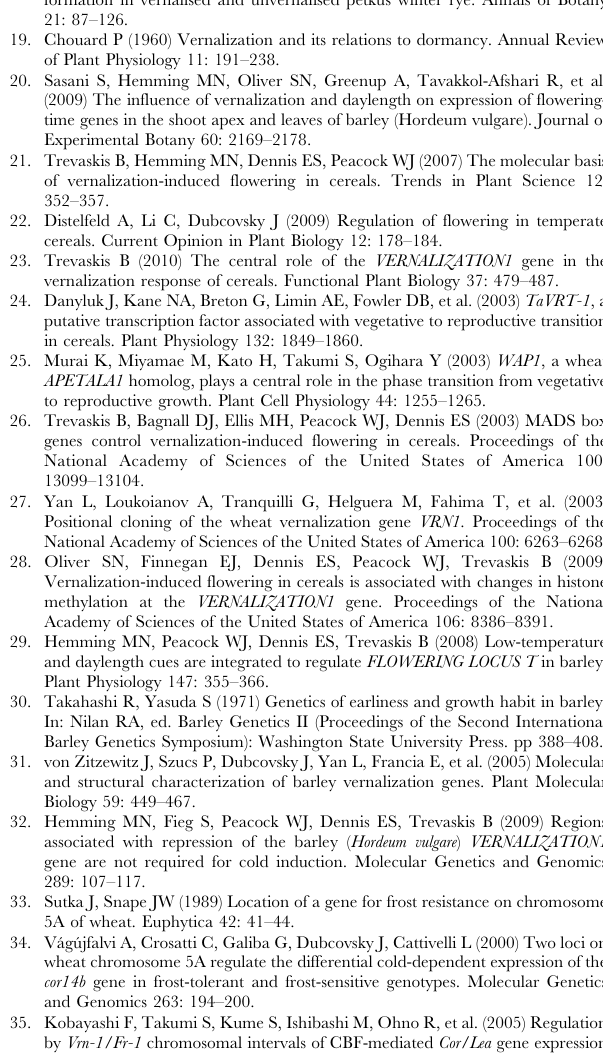
Table S7 Numbers and descriptions of contigs clustered together according to expression behaviour.